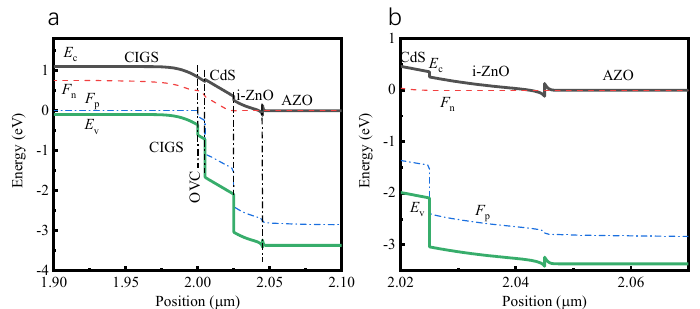
Figure 5. Energy band diagram of ( a ) CIGS solar cell and ( b ) magnified along i−ZnO/AZO in equilibrium under the illustration of AM1.5 G at 300 K simulated via SCAPS−1D software.